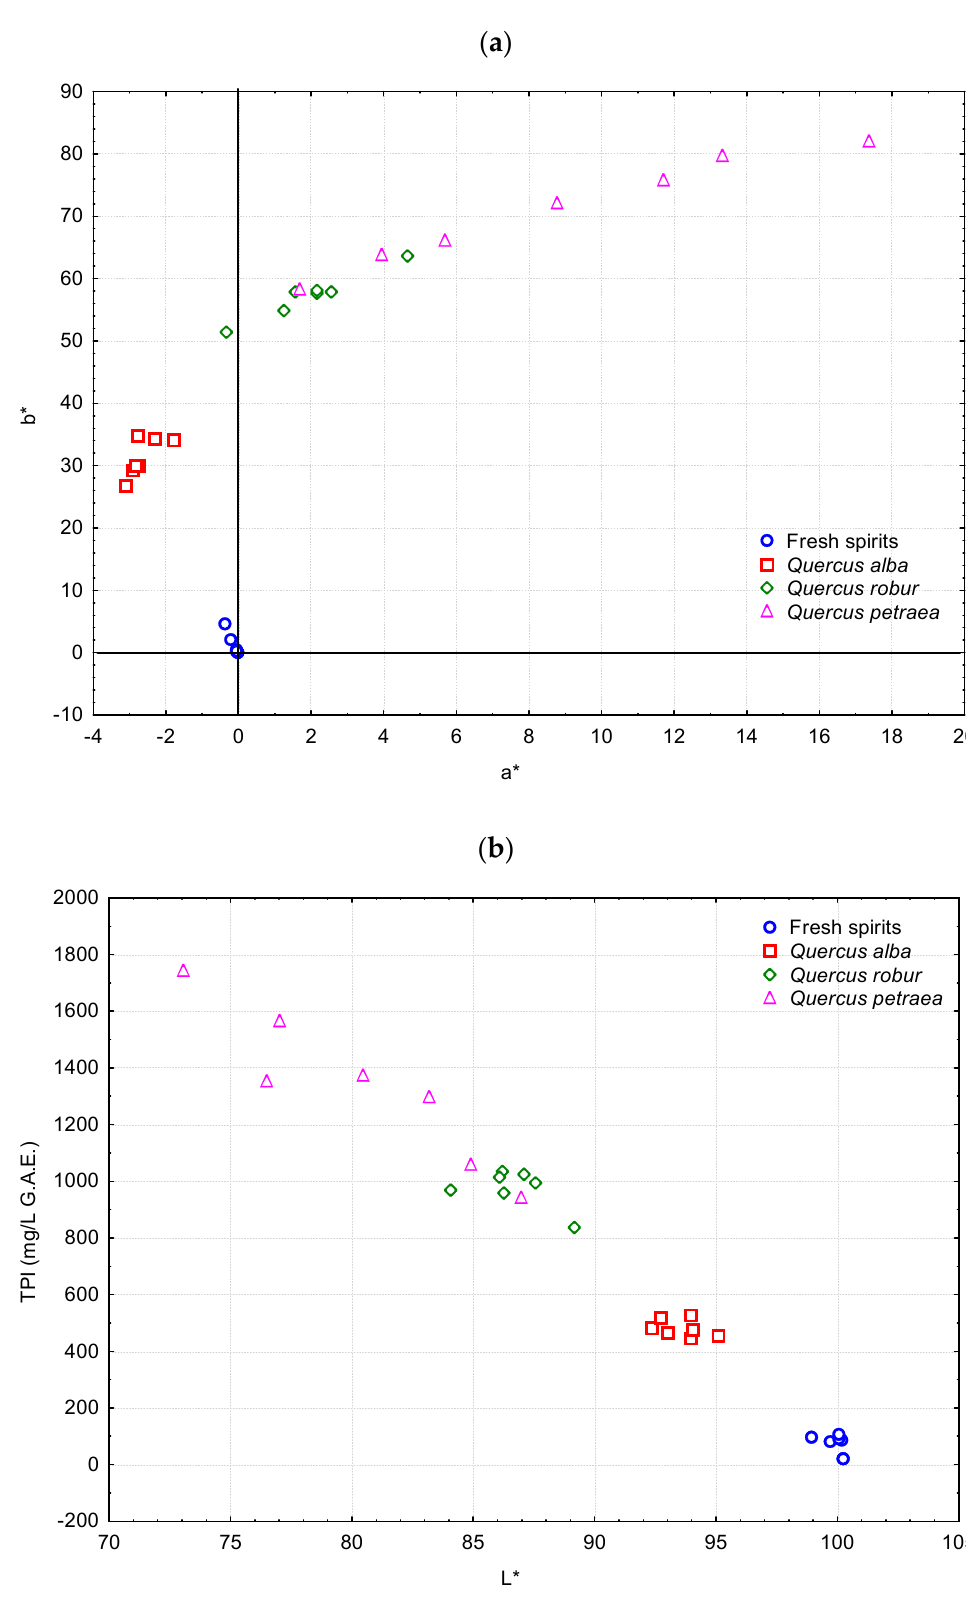
Figure 2. Dispersion plots of the brandies on the a*-b* ( a ) and L*-TPI ( b ) planes. The relative distances between the brandies in contact with the different oak species that had already been observed in the cluster analysis can be confirmed. Those aged in Quercus alba (QA) are characterized by greenish tones (a* negative trait), enhanced bright- ness (higher L*), and lower total polyphenol contents, which suggests a lower occurrence of the extractive phenomena. The brandies aged in Quercus robur (QR) showed reddish tones (a* positive trait) and a greater contribution of yellow hues (greater b*), an interme- diate luminosity, and medium polyphenol contents. On the other hand, the brandies in contact with Quercus petraea (QP), in contrast to the previous ones, displayed a large dis- persion, which could perhaps be attributed to the greater heterogeneity of the casks used